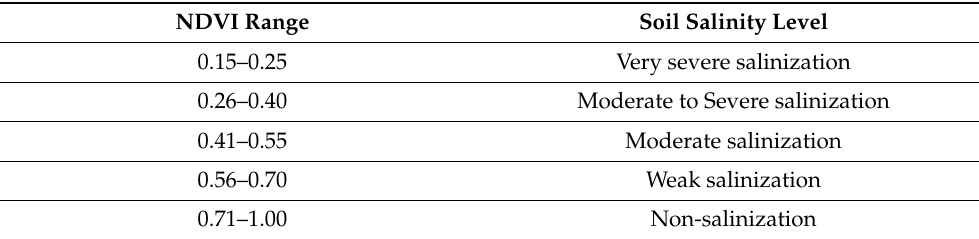
Table 7. Hypothetical NDVI range for soil salinity levels